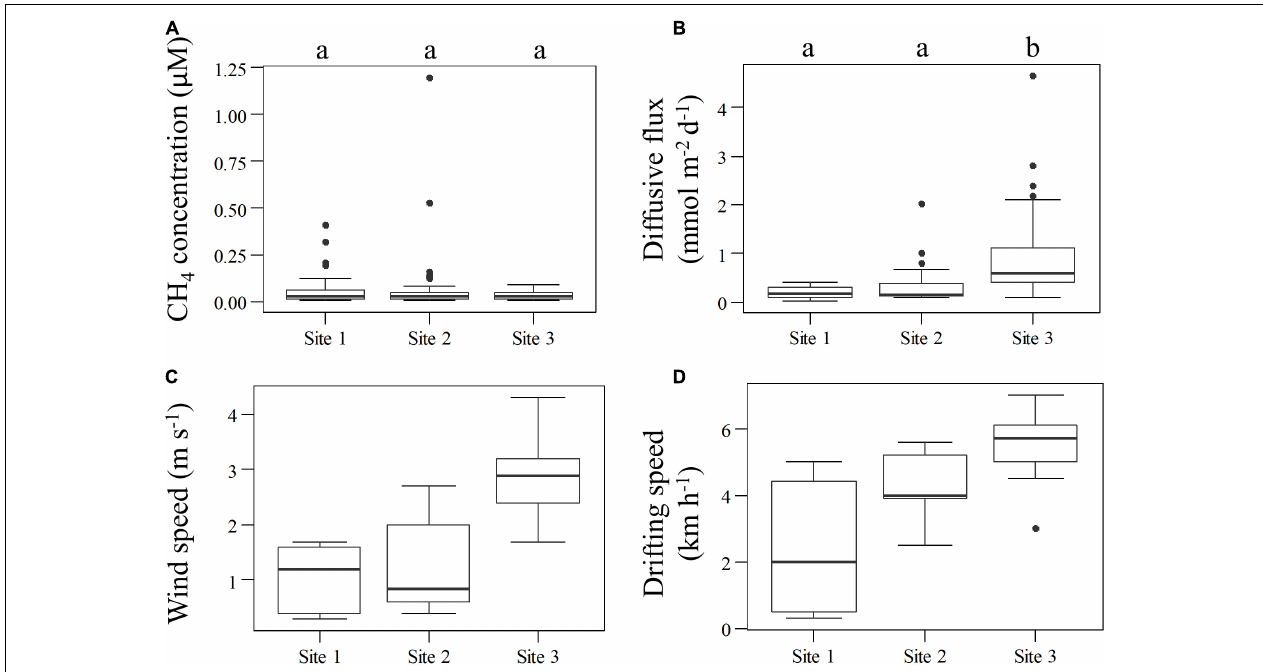
FIGURE 5 | CH 4 concentration (A) , diffusive flux (B) , wind (C) , and water speed (D) variation for each site. The small letter above CH 4 concentration and diffusive flux charts show grouping according to ANOVA, p < 0.01 followed by a Tukey post-hoc test ( p < 0.05). Wind and drifting speed do not show grouping statistics because of the small number of measurements, and consequently, not meeting assumptions requirements for the statistical test.